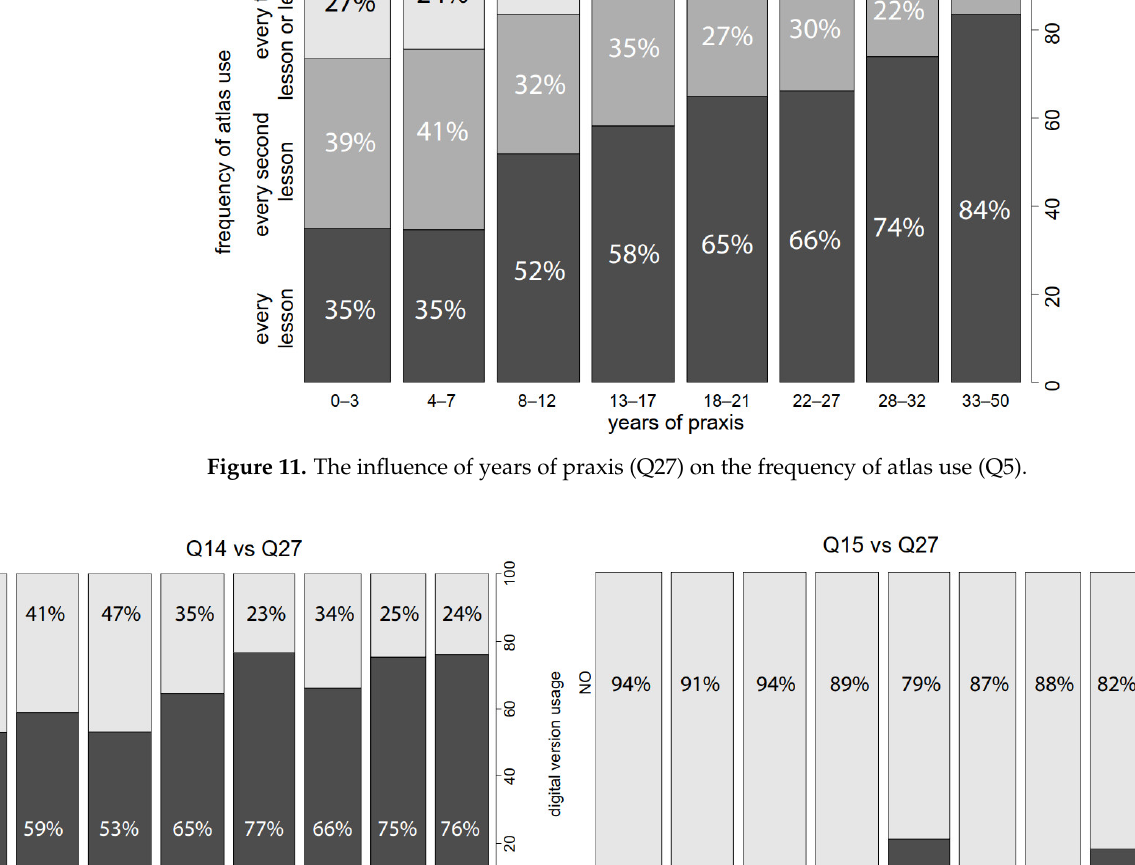
Figure 11. The influence of years of praxis (Q27) on the frequency of atlas use (Q5).